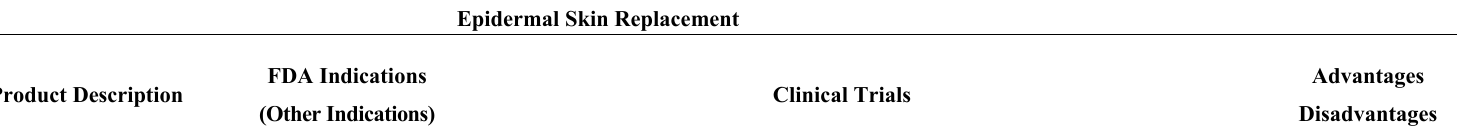
Table 2. Skin substitutes for wound